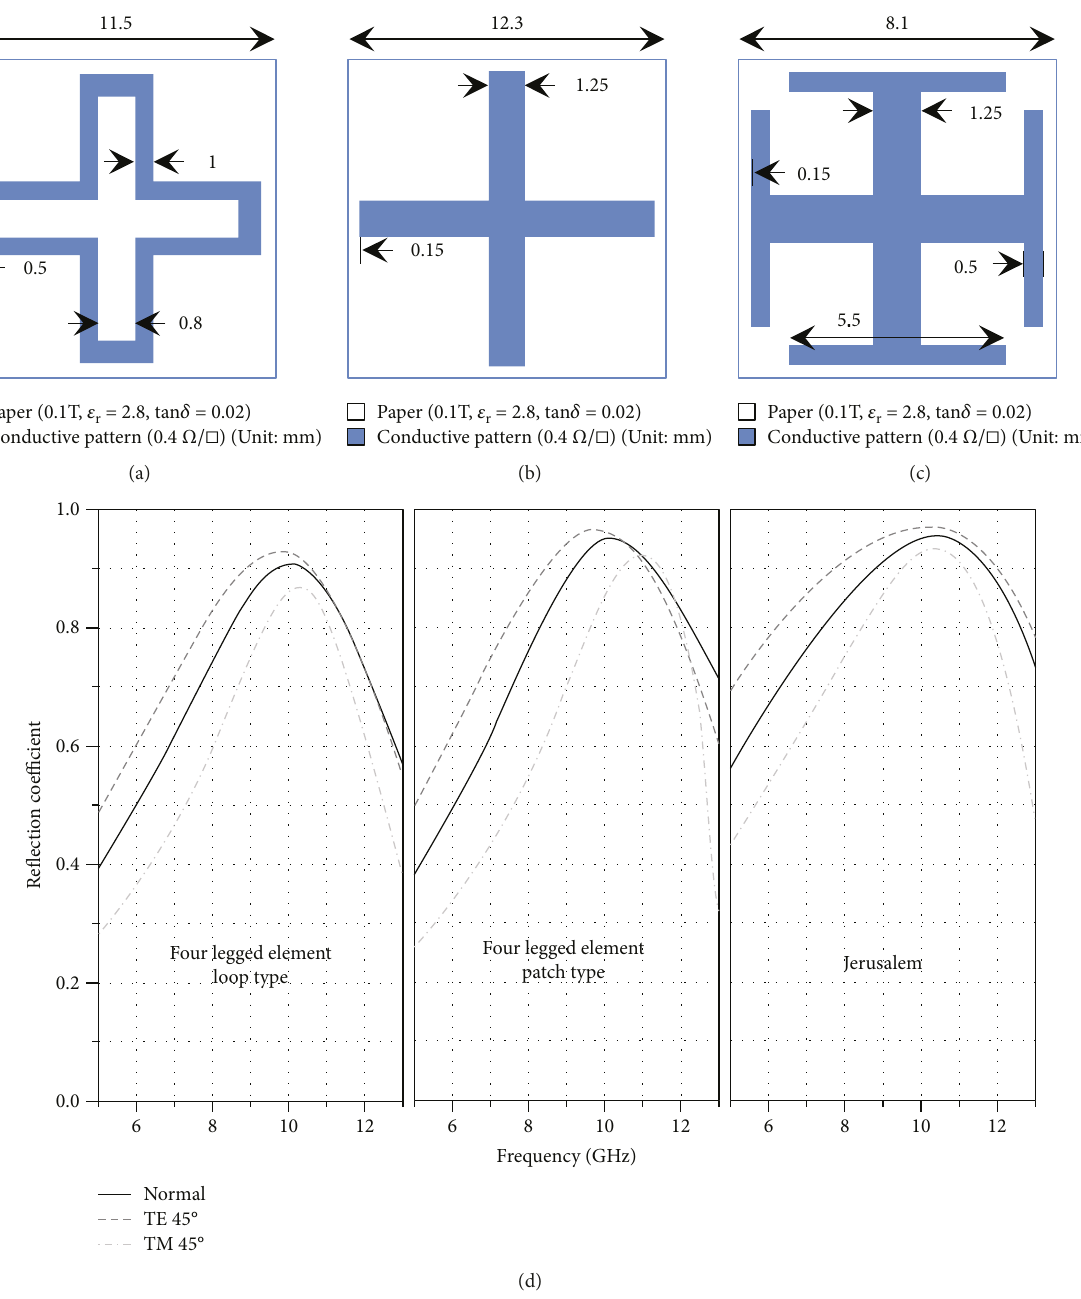
Figure 1: Proposed FSS unit cell and simulation results: (a) loop type; (b) patch type; (c) Jerusalem cross type; (d) free space measurement